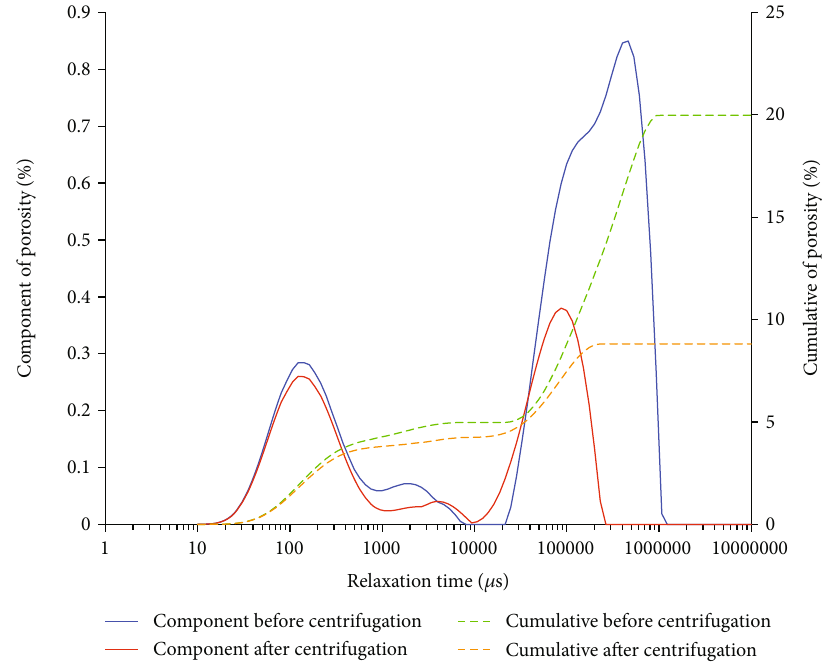
Figure 4: NMR T spectrum of core in well DF51 at 1442.54m. 2